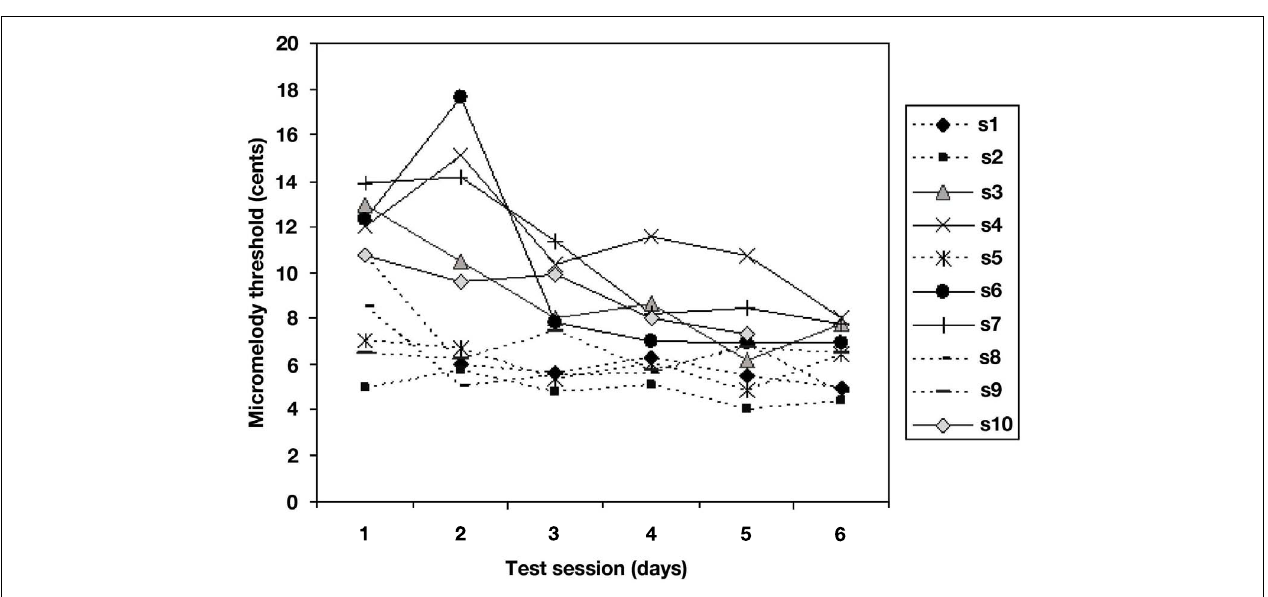
the first or second day (termed faster learners, dotted lines); the other five (slower learners, solid lines) showed more gradual improvement over the 6-day period.The two subgroups did not differ in terms of final